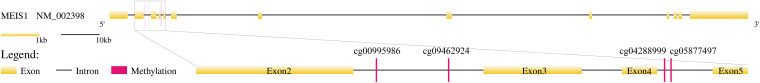
The four methylation sites on the gene structure of MEIS1. MEISI is a long gene of 1,40,418 bps with 13 exons. The methylation sites cg00995986 and cg09462924 located between exon 2 and exon 3 while cg04288999 and cg05877497 located between exon 4 and exon 5 in MEIS1. They were close on chromosome position.